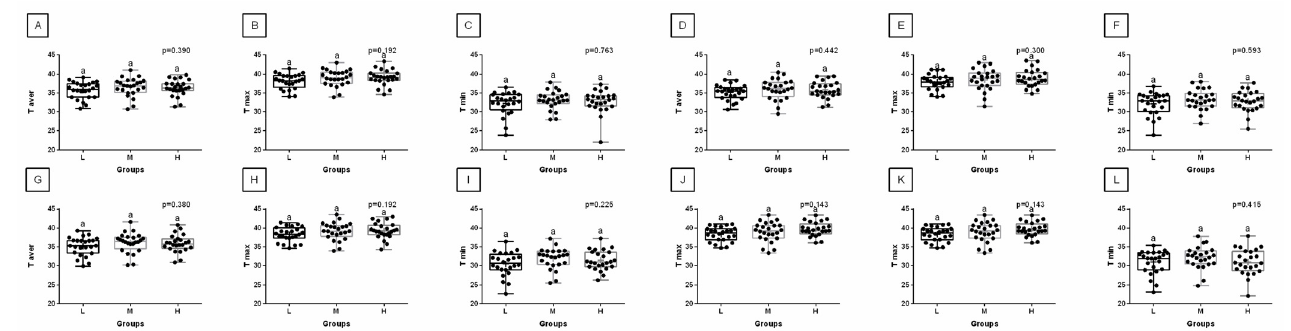
Figure 3. Features of conventional thermography compared between the light (L), moderate (M), and heavy (H) groups in consecutive regions of interest (ROI 1, ( A – C ); ROI 2, ( D – F ); ROI 3, ( G – I ); ROI 4, ( J – L )). Differences between groups were indicated with individual p -values when p < 0.05. Different superscripts on each plot were statistically different. ( A , D , G , J ) Taver—average temperature;